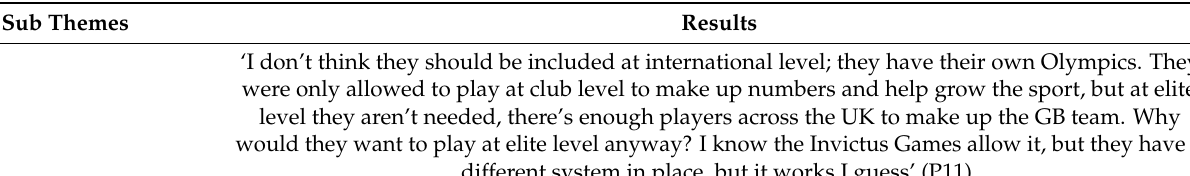
Table 4. Players’ views on able-bodied participation at international